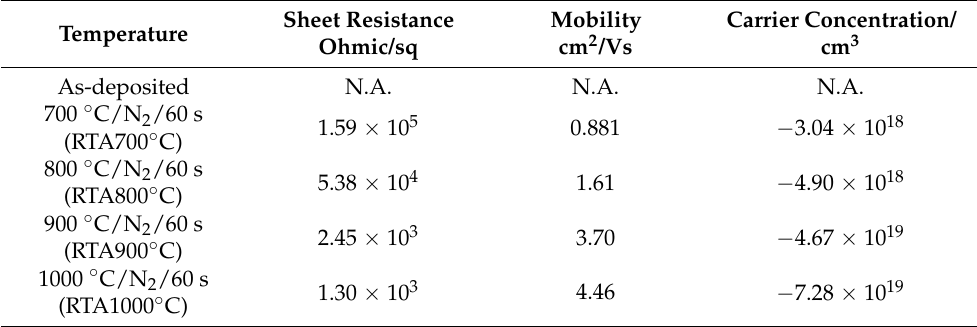
Table 1. Hall measurement results for the as-deposited and annealed Zr-doped Mg x Zn 1 − x O films.